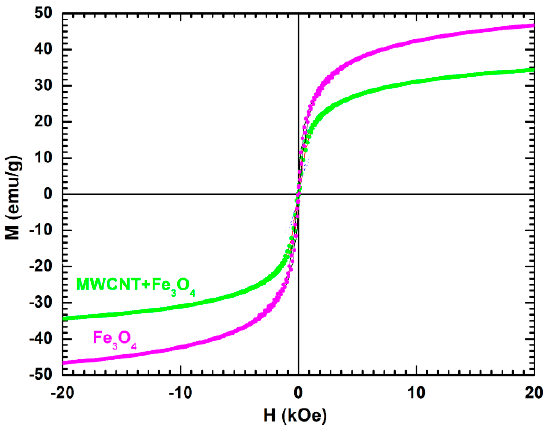
Figure 4. Magnetic results of the synthesis MWCNT + Fe 3 O 4 hybrid nanoparticles.